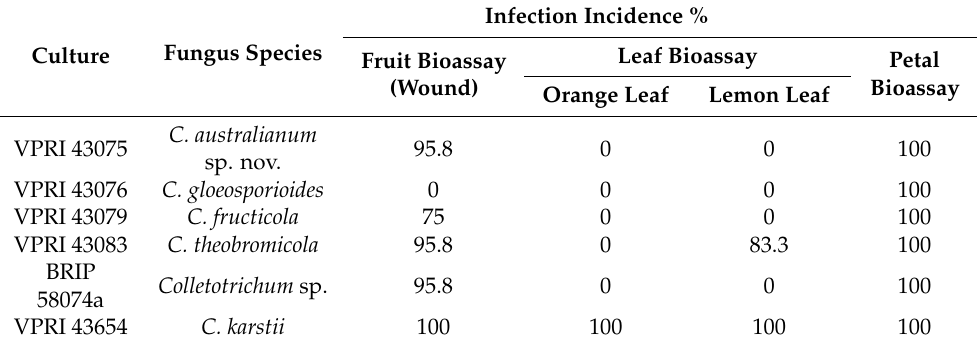
Table 4. Incidence of infection on Washington Navel orange fruit and leaves and Meyer lemon leaves by Colletotrichum